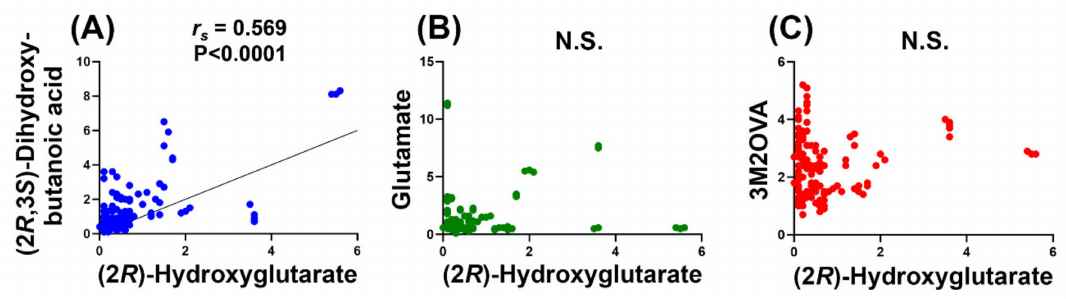
Figure 3. Correlations between (2 R )-hydroxyglutarate and ( A ) (2 R ,3 S )-dihydroxybutanoic acid, ( B ) glutamate, and ( C ) (3 S )-methyl-2-oxovaleric acid. Correlation analysis was conducted using the nonparametric Spearman rank correlation, which was highly significant for (2 R )-hydroxyglutarate and (2 R ,3 S )-dihydroxybutanoic acid ( r s = 0.569; p < 0.0001) but not significant (N.S.) for either glutamate or (3 S )-methyl-2-oxovaleric